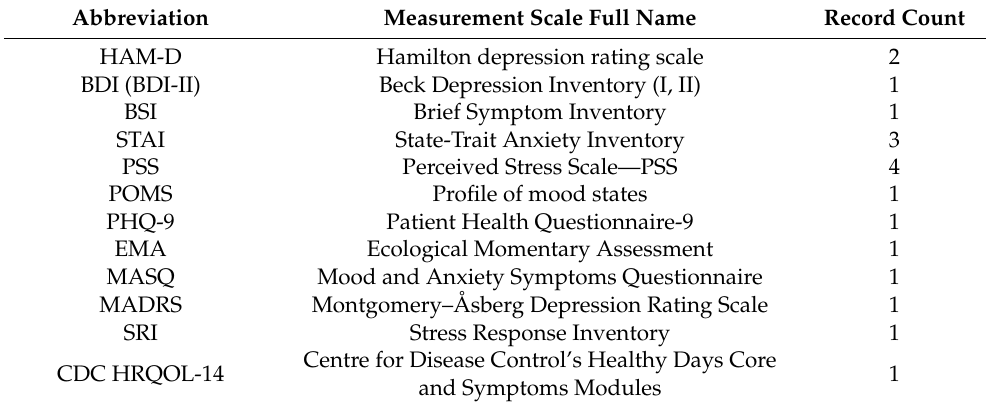
Table 3. Evaluation scales including abbreviation, full name and record count within the in- cluded